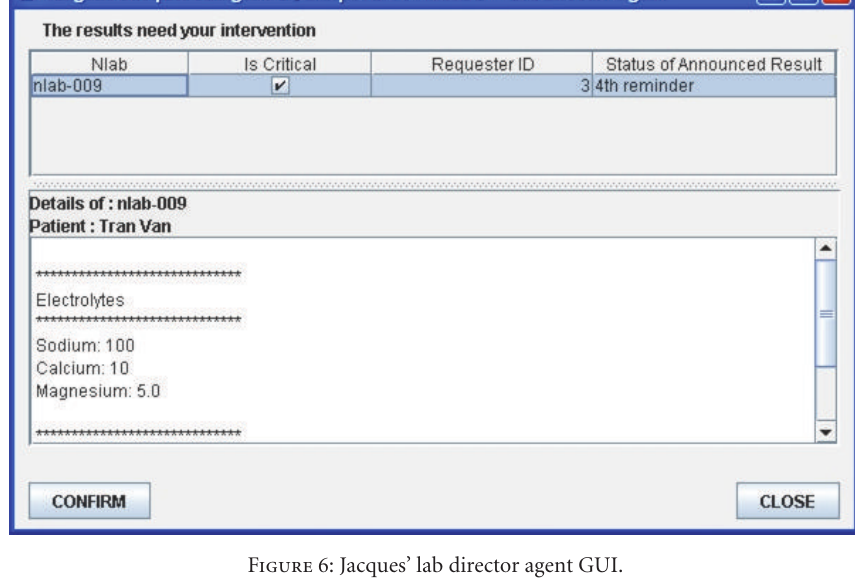
Figure 6: Jacques’ lab director agent GUI.